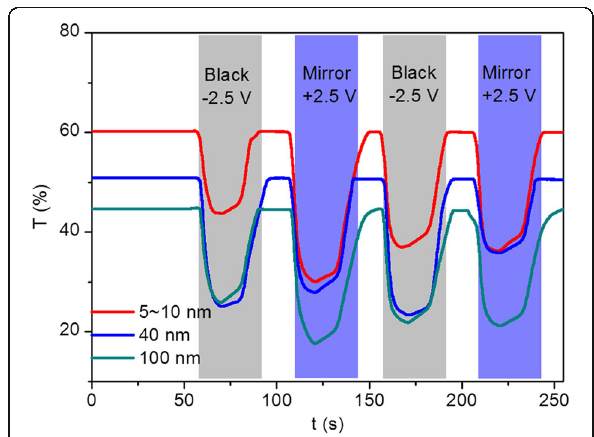
Fig. 4 (Color online) Transmittance variations at 700 nm obtained during two-electrode CV tests for devices modified with TiO 2 nano- particle sizes of 5~10 ( red ), 40 ( blue ), and 100 nm ( green ), respectively